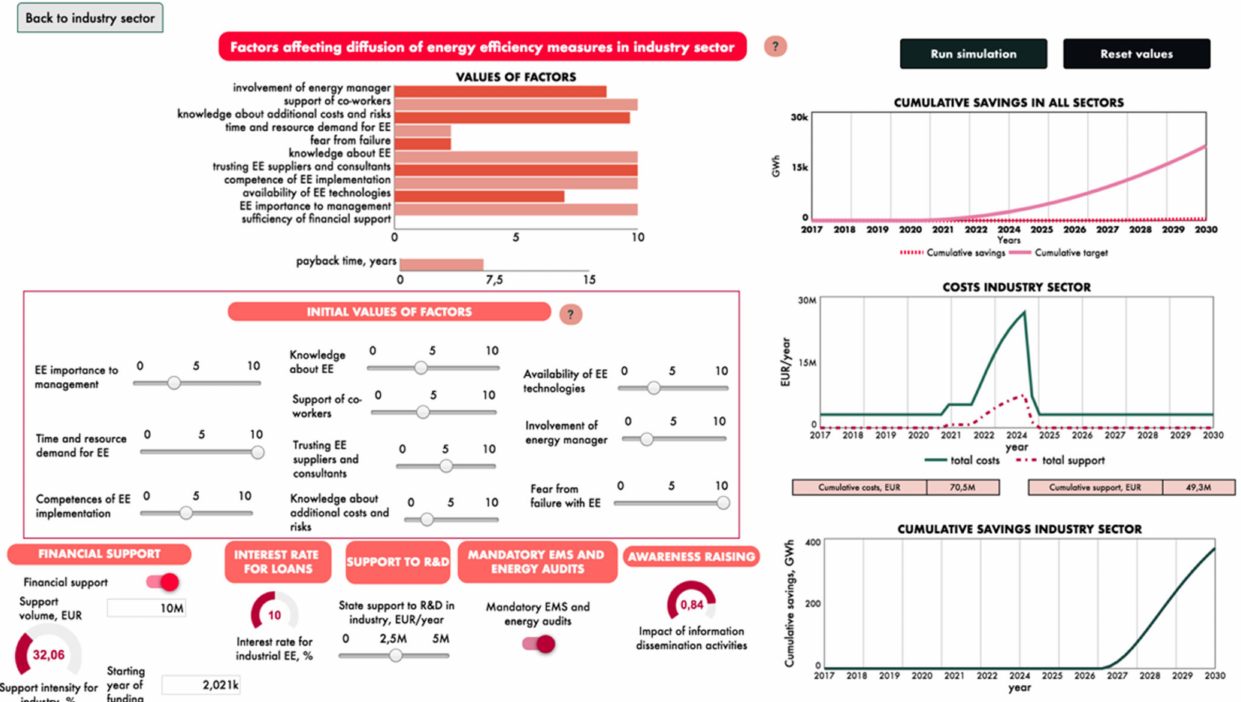
Figure A7. The second layer of Internet-based model interface for selection of policy tools for industry sector.